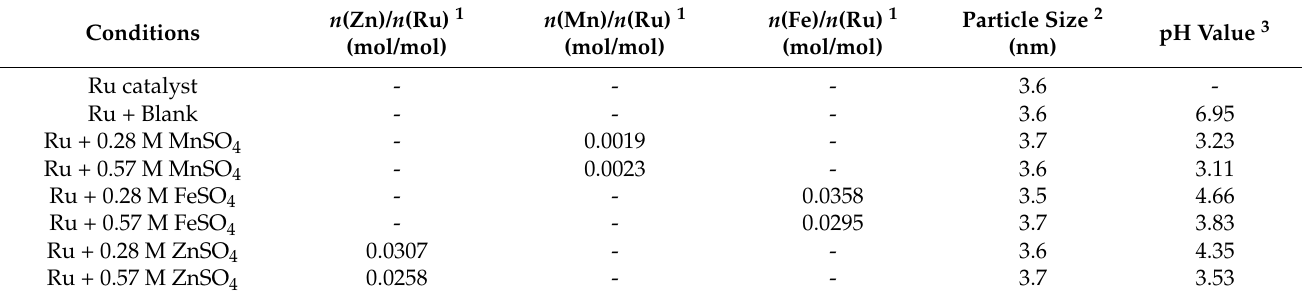
Figure 1. XRD patterns of the monometallic Ru catalyst after catalytic experiments applying different amounts of ZnSO 4 , FeSO 4 , and MnSO 4 as reaction modifiers. Table 1. Composition and particle size of the monometallic Ru before and after catalytic experiments with different amounts of reaction modifiers as well as the pH value of slurry.